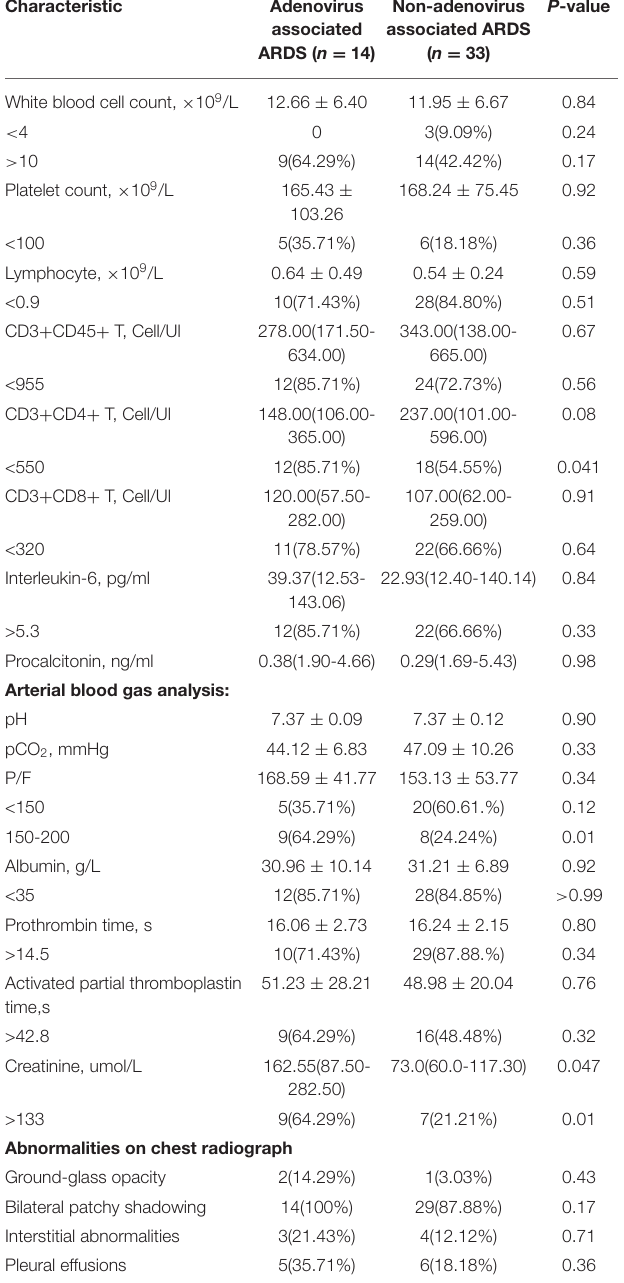
TABLE 2 | Laboratory findings and radiographic results for patients with adenovirus-associated ARDS.